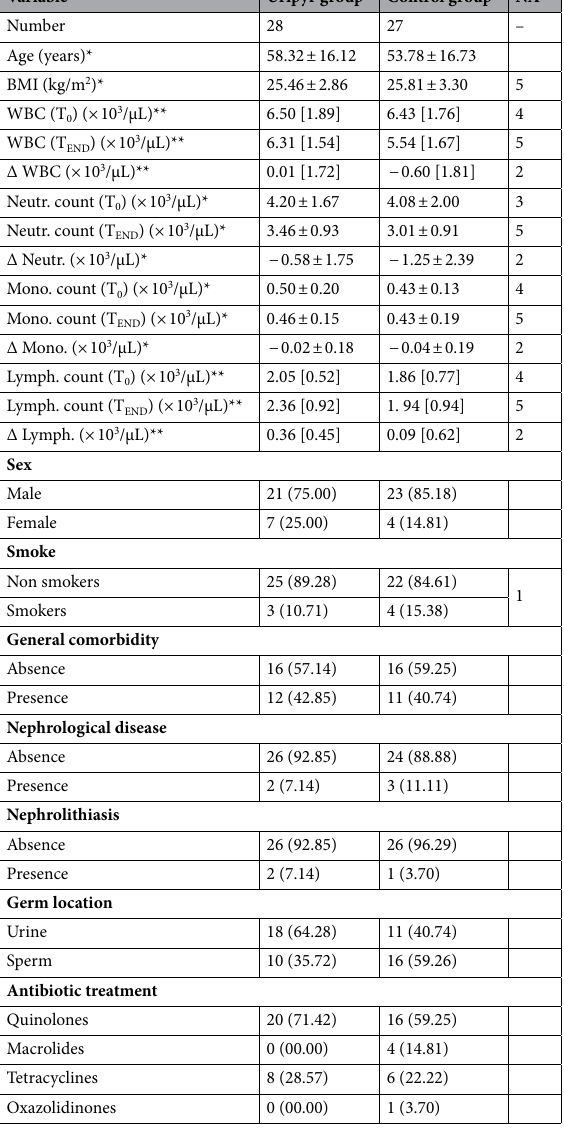
Table 1. Demographic and clinical features of the enrolled patients. Values are expressed as mean ± Standard Deviation or median [IQR] respectively for normal (*) and non-normal (**) distributed numeric variables, and with n (%) for categorical ones. Each item was compared among the 2 groups using t-test or Mann– Whitney’s U test for quantitative variable and Pearson χ 2 test for categorical ones. A level of significance of P < 0.05 (two-sided) was used to compare Uripyr and control group. NA number of patients for which the corresponding data were not available, BMI Body Mass Index, WBC (T 0 ) white blood cells count at baseline (T 0 ), WBC (T END ) WBCs count at the end of treatment (T END ), Δ WBC differential count of WBCs (T END − T 0 ), Neutr. (T monocytes count at the end of treatment (T END ), Δ Mono. differential count of monocytes (T END − T 0 ), Lymph.